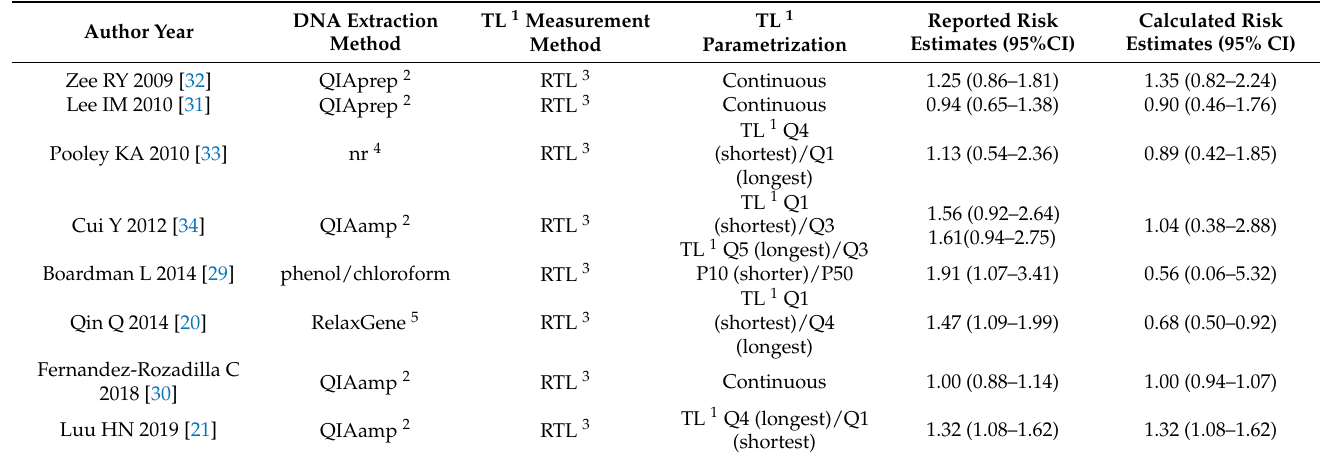
Table 2. Characteristics of telomere length measurements in peripheral blood leukocytes of n = 8 studies and the reported colorectal cancer risk estimates compared with the calculated risk estimates (4th quartile vs. 1st quartile [Q4/Q1]).